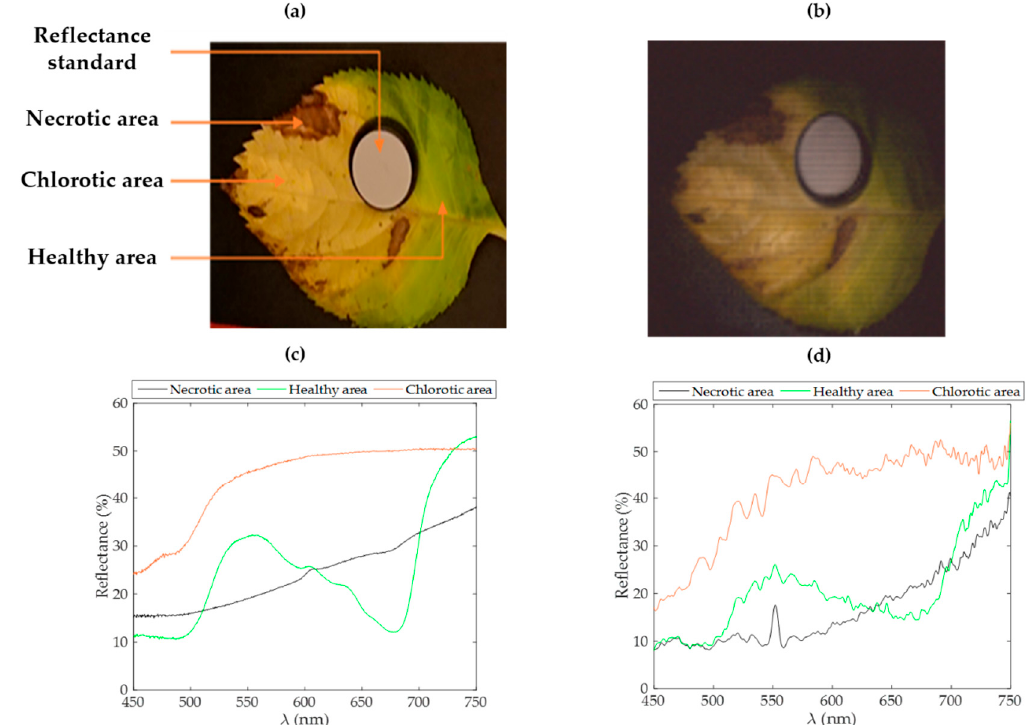
Figure 4. Detection of different health states within a hydrangea leaf. ( a ) Photography of the scene. ( b ) A 101 × 101 pixels false color image reconstructed in HSPI using Gerbil. Comparison of each element’s spectra, as established by point measurements ( c ) and from the HSPI hypercube ( d ). Curves have been smoothed with a moving average filter with a span of 5 pixels.